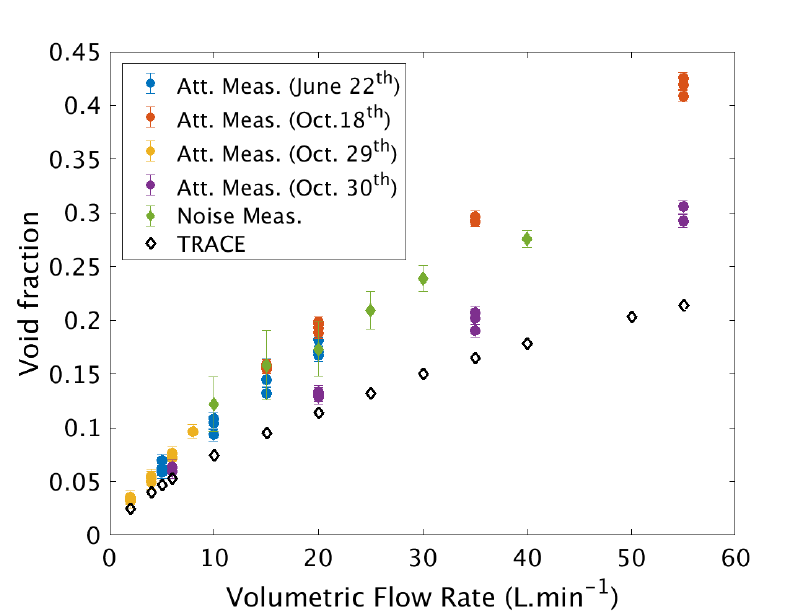
Figure 4: Comparison of void fraction produced through simulation (TRACE) and measurements in the VOID channel through gamma attenuation (Att. Meas.) and neutron noise (Noise